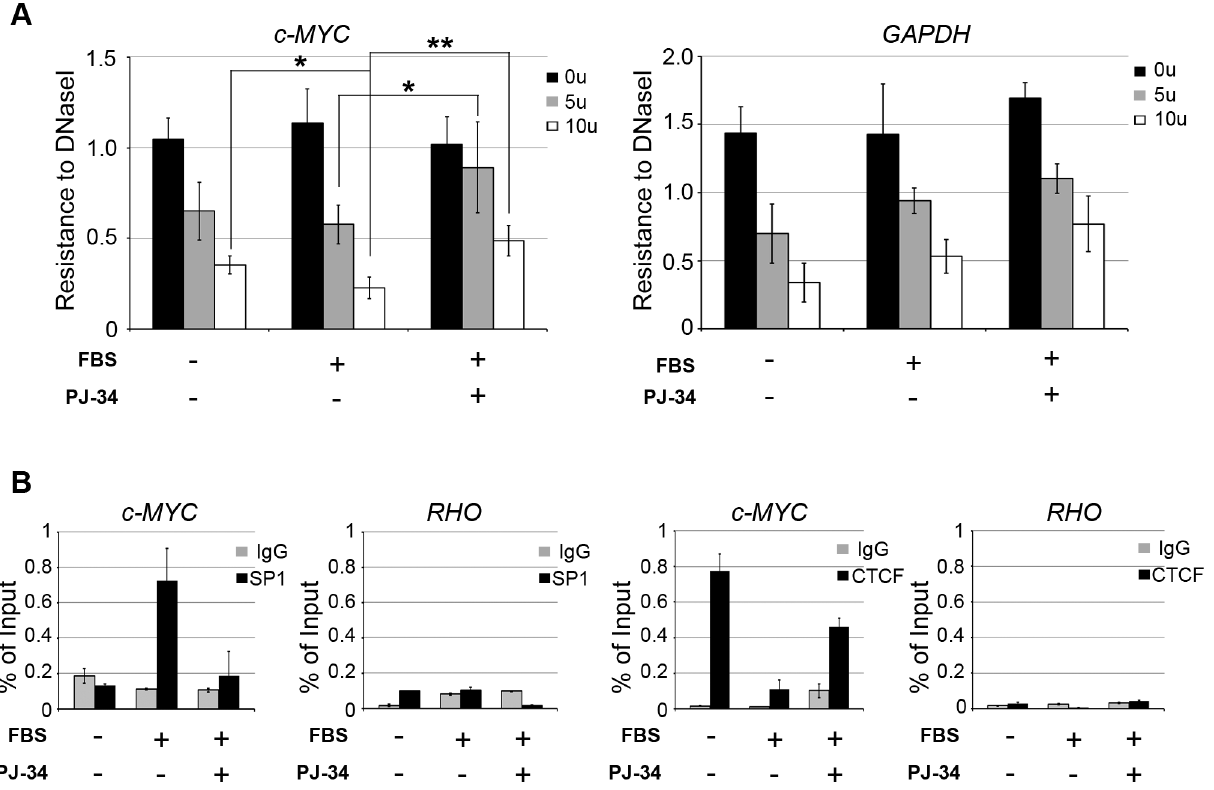
Figure 4. PARP activity promotes an active chromatin status at c-MYC promoter. A, DNAseI accessibility assays on c-MYC promoter. Quiescent (-FBS) and 30-minutes serum-stimulated ( + FBS) fibroblasts were treated or not with the PARP inhibitor PJ-34. The entire nuclei were isolated and treated with 5 or 10 units of DNaseI or left untreated. After purification DNAs were analyzed by semi-quantitative PCR with a primer pair specific for the fragment 2 of c-MYC promoter. Densitometric-values obtained for c-MYC and GADPH promoters were normalized respect to those obtained for RHO promoter. Data are plotted as mean 6 SD of four biological replicates. Statistical significances: *: P , 0.05; **: P , 0.01 (Student’s t test). B, ChIP analysis of c-MYC promoter occupancy by SP1 and CTCF. Chromatin samples from cells treated as above were immuno-precipitated with antibodies specific for SP1 or CTCF or normal rabbit IgG. Input and immuno-precipitated samples were subjected to qPCR amplification with a primer pair specific for the region covering the fragment 2 and 3 (fr.2 + 3) of c-MYC promoter region (c-MYC) and for RHO promoter used as a negative control. The results shown are representative of two independent experiments and plotted as described in Figure 3A.